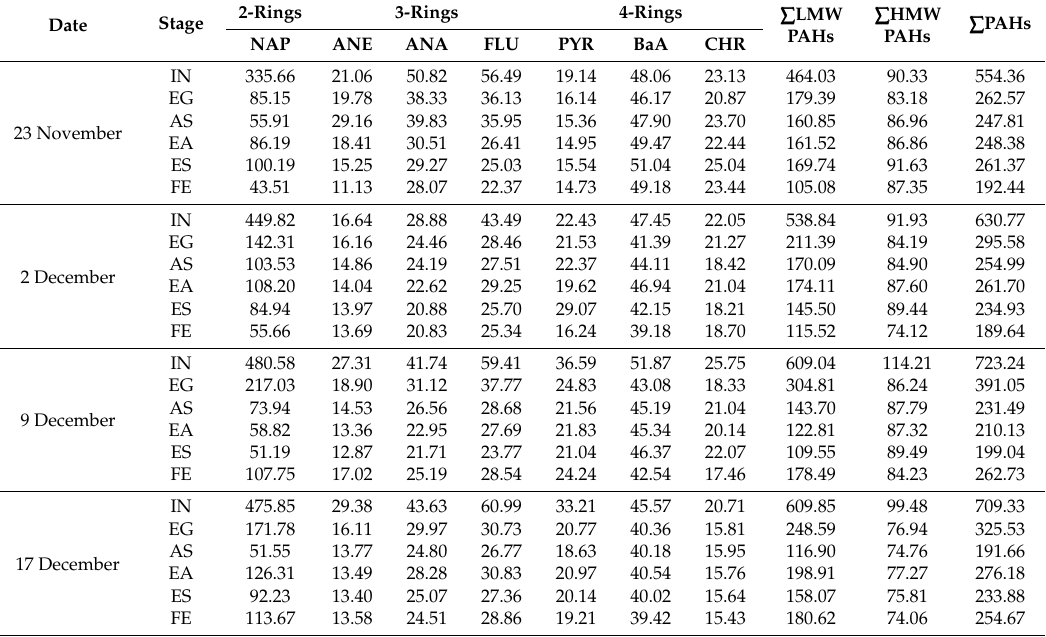
Table 1. Concentration of PAHs at various stages of sewage treatment (ng/L).